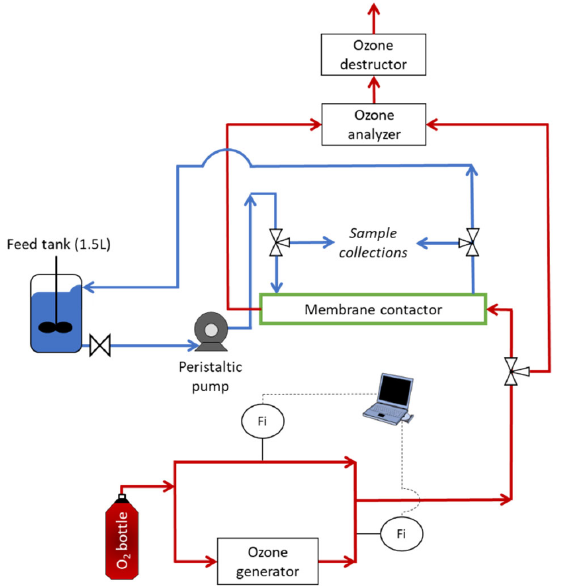
Figure 2. Flowsheet of the ozonation pilot; liquid in closed loop; gas in open circuit (red: gas stream; blue: liquid stream).